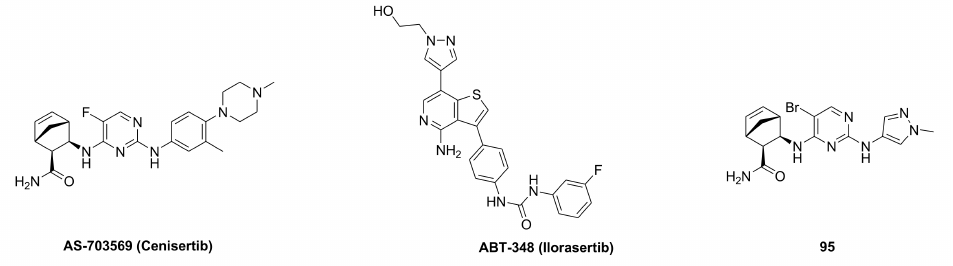
Figure 99. Structures of cenisertib, illorasertib, and compound 95